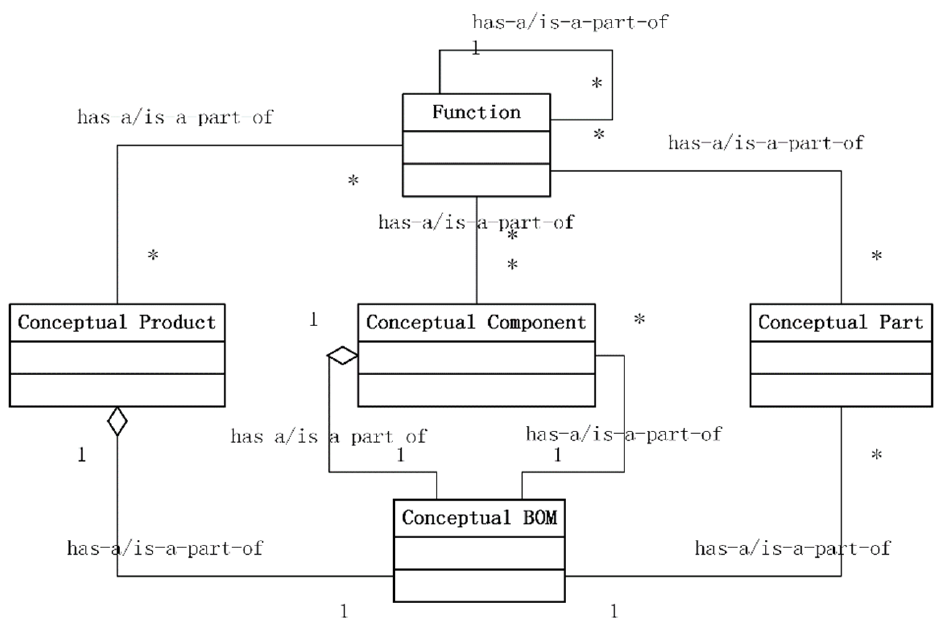
Figure 3. CPhDM. (* represent the